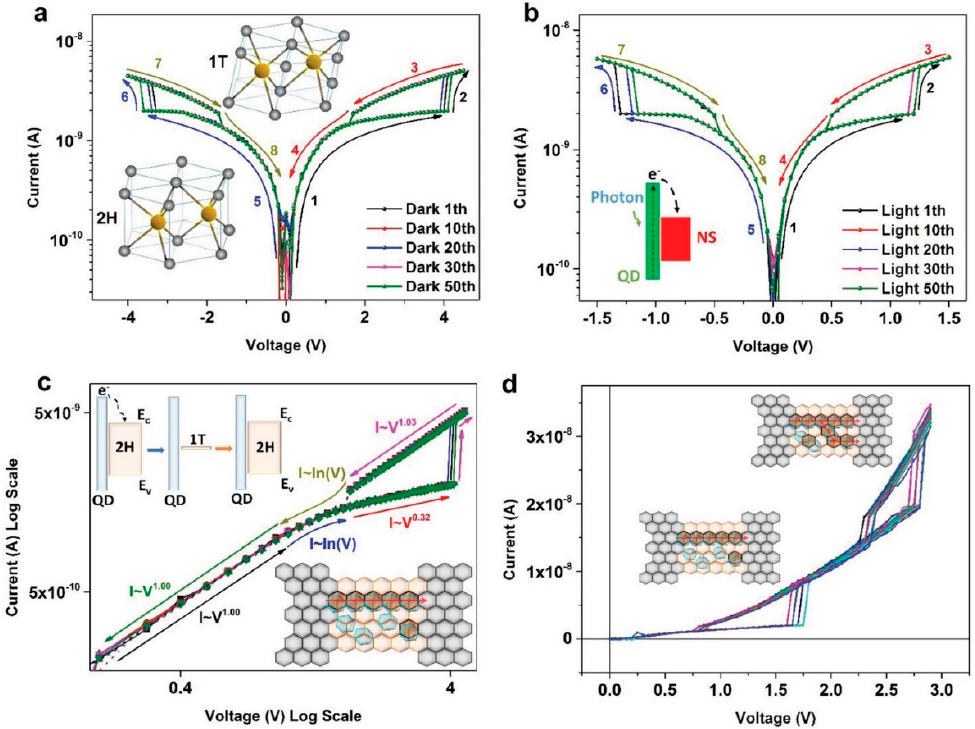
Figure 22. ( a , b ) Current-voltage characteristics of the MoS 2 QDNS H1 structure with graphene electrodes for 50 cycles on a logarithmic scale in the dark and in the light, respectively. The inset in ( a ) schematically shows the 2H-1T phase transition from the trigonal prismatic (D 3H ) to octahedral (O H ) structure; atoms in the lattice: molybdenum (yellow), sulfur (gray). The inset in ( b ) shows a diagram of the process of photoexcited electron transfer. ( c ) I-V characteristics from ( a ) on a logarithmic scale. Insets in ( c ) show diagrams of the corresponding charging and discharging processes. Graphene, 2H-MoS 2 , 1T-MoS 2 , and MoS 2 QDs are displayed in gray, light yellow, brown, and blue, respectively. ( d ) Two-level resistive switching of the graphene/MoS 2 QDNS/graphene structure with ≈ 5.5 × 10 4 QDs µ m − 2 in the dark. The insets show diagrams of the formation of filaments from the 1T phase. Reproduced with permission from [170]. Copyright WILEY-VCH Verlag GmbH & Co. KGaA, Weinheim, 2019.